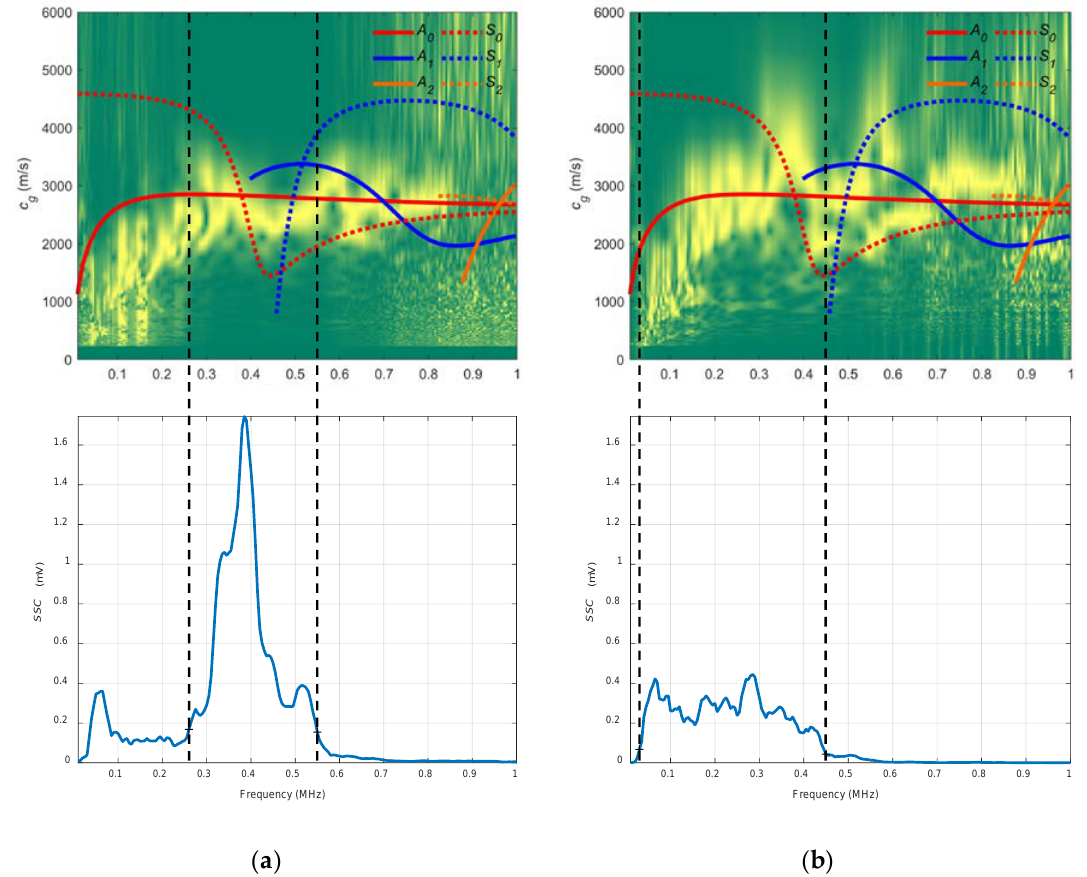
Figure 17. Incidence angle dispersion curves for a mortar plate and water as the coupling medium ( 1490 m/s). The chosen angles (20°, 40°) are represented by black discontinuous curves. 𝑐𝑐 =